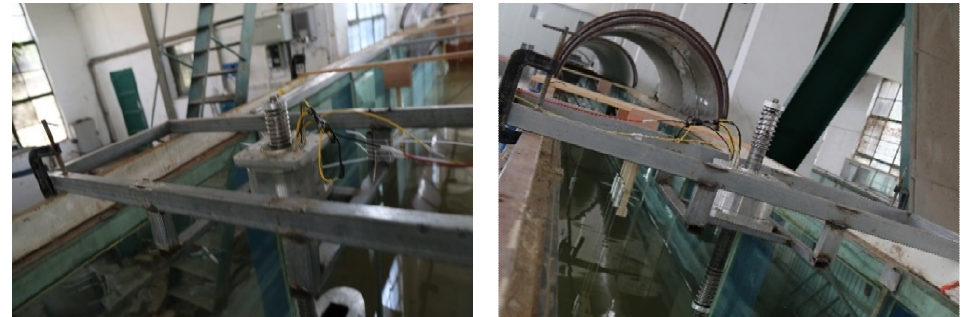
Figure 4. The permanent magnet single phase linear motor installed in flume.